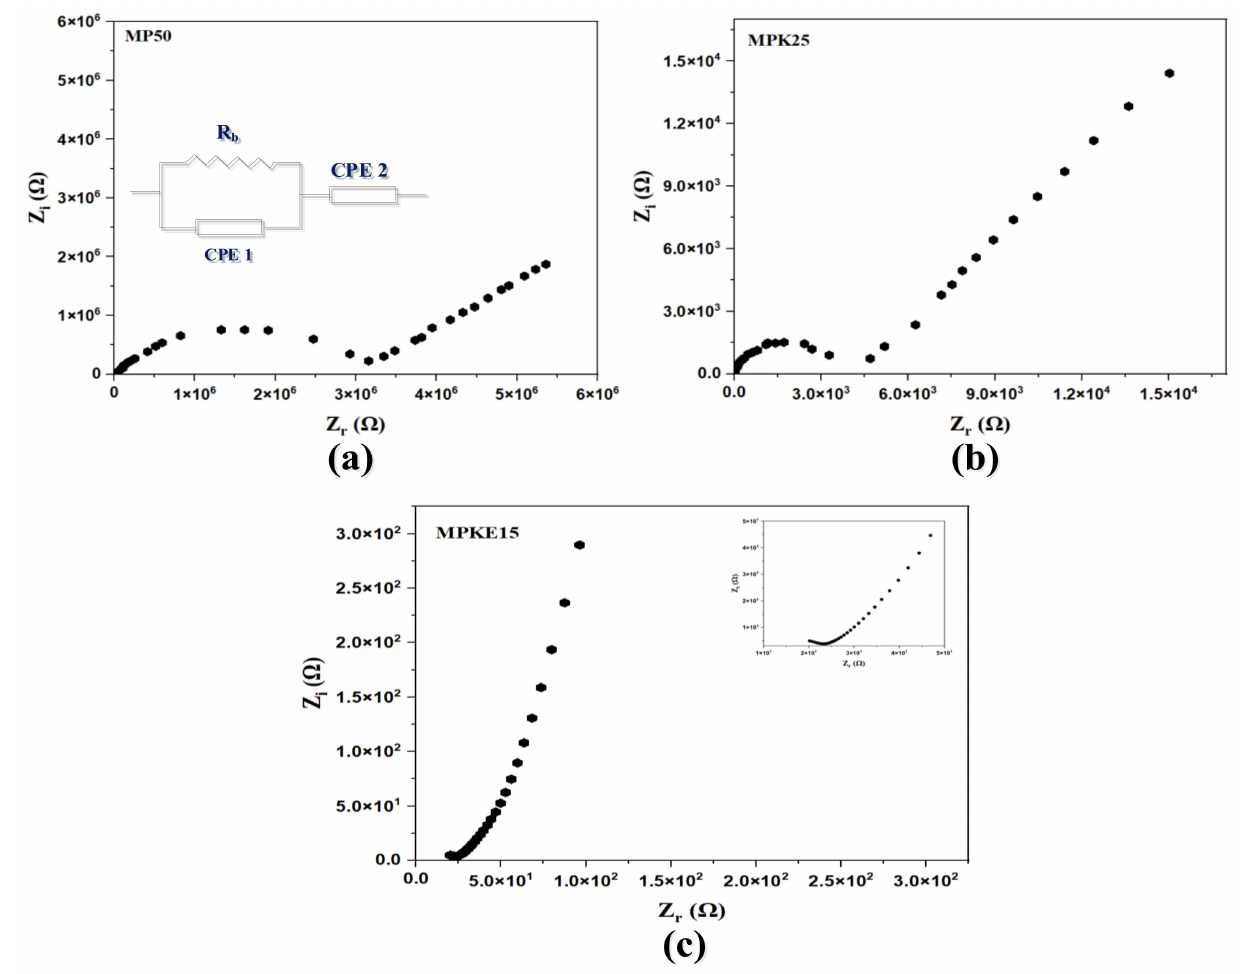
Figure 9. Nyquist plots of selected MC/PVP-based SPE with associated ECC. ( a ) MP50, ( b ) MPK25 and ( c )